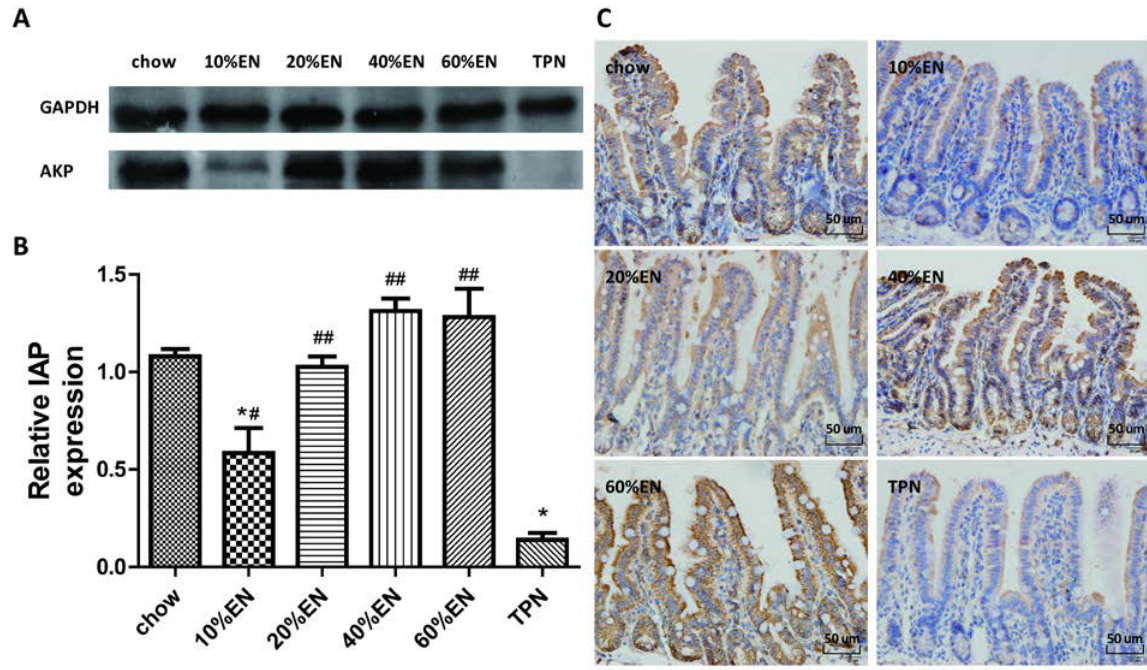
Figure 3. Intestinal alkaline phosphatase (IAP) levels in the ileal tissue. ( A ) IAP protein bands, as detected by Western blot analysis; ( B ) IAP levels in the ileal tissue. Data are presented as the mean ± standard error of the mean (SEM). * p < 0.001 vs. chow. # p < 0.05